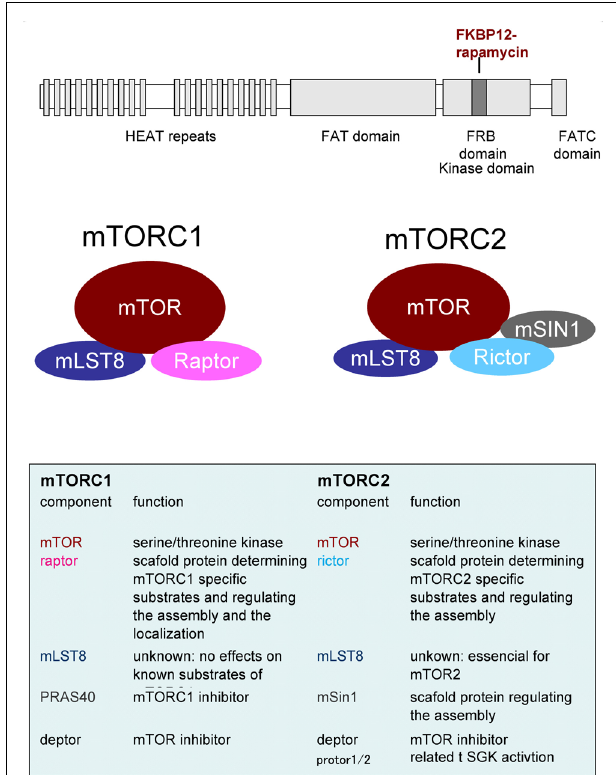
FIGURE 1 | Upper panel. Domain structure of mTOR. HEAT: H untington E longation Factor 3 PR65/ AT OR, FAT: F RAP A TM T TRAP, FRB: F KBP12- R apamycin B inding. Middle and lower panel: Components of mTOR